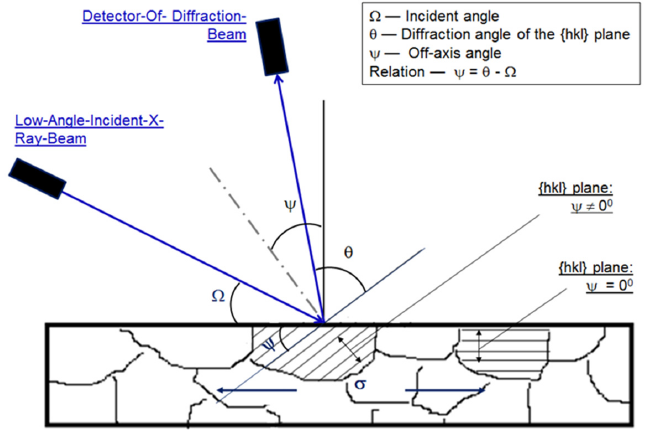
Figure 1. A schematic diagram showing the geometric set ‐ up of X ‐ ray diffraction (XRD) residual stress measurements.